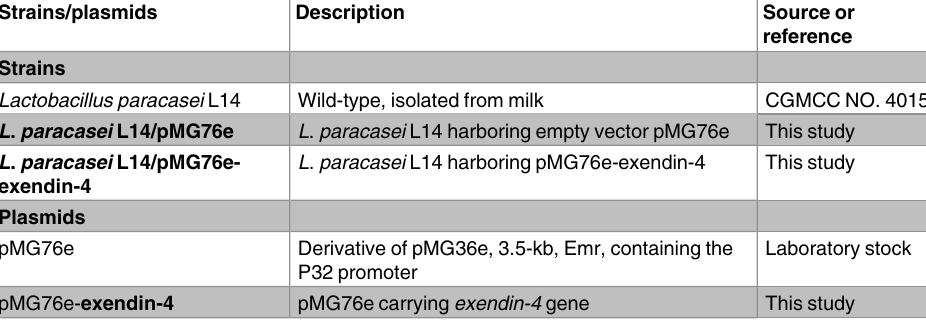
Table 1. Bacterial strains and plasmids used in this